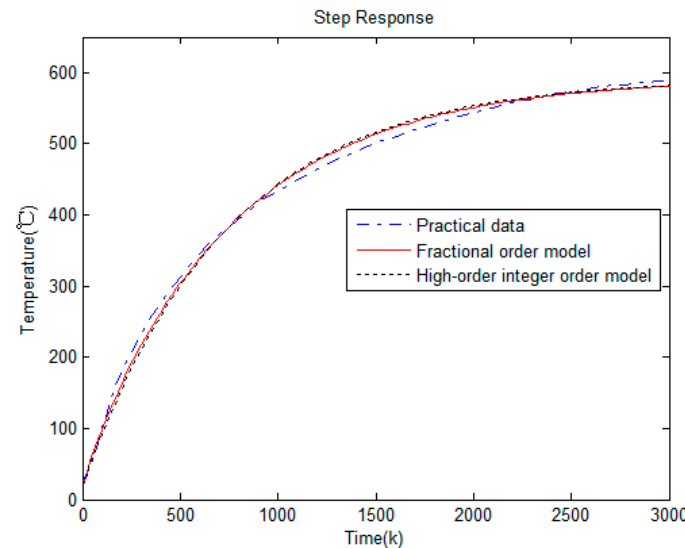
Figure 4. The practical temperature data and the response curve of the two models.